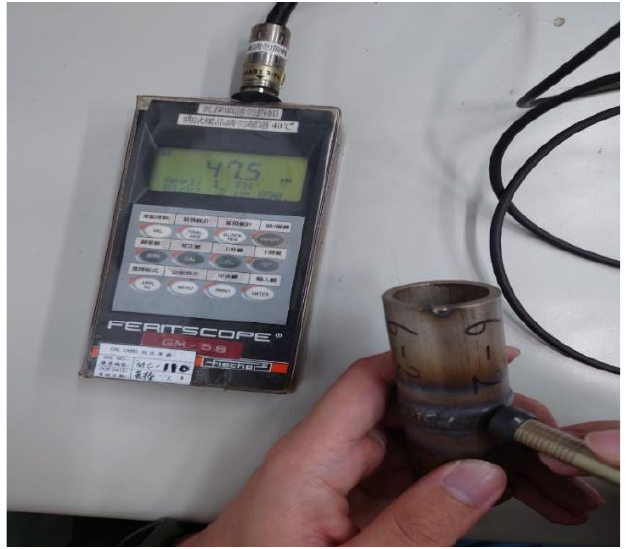
Figure 2. Percentage detection of the test piece with a ferritic rate meter.